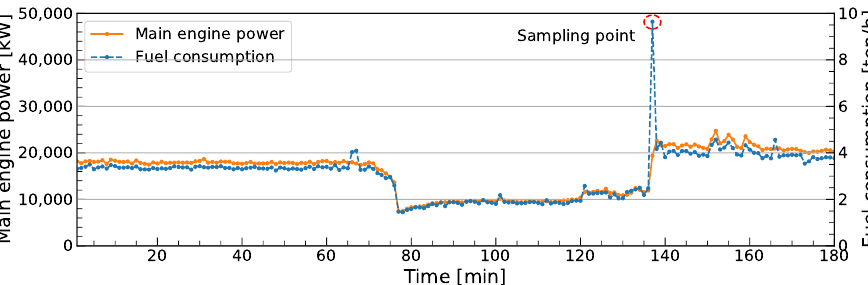
Figure 2. Trend of main engine power and fuel consumption data around sampling